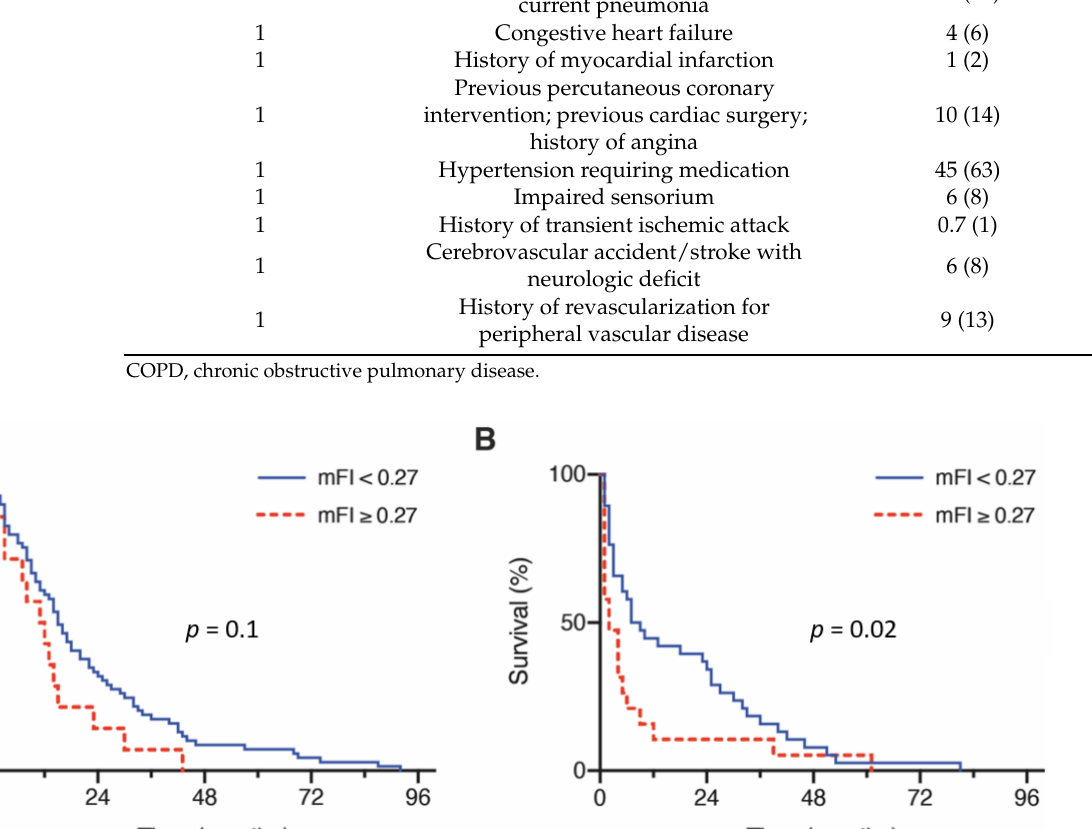
Table 2. Frequency of Patient Frailty According to the Modified Frailty Index.